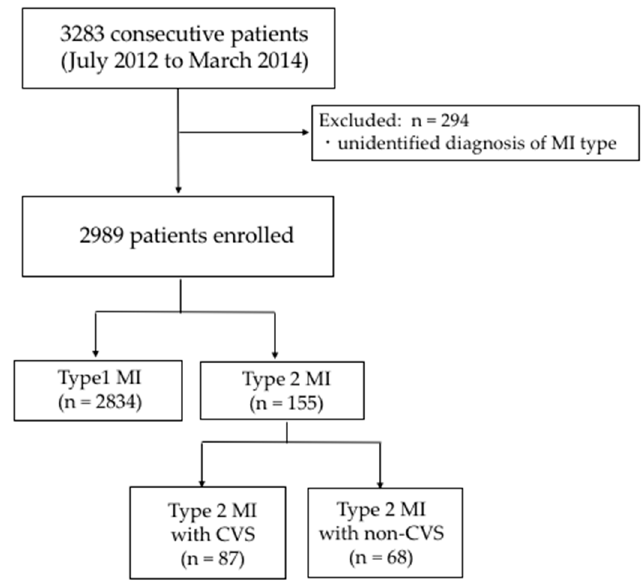
Figure 1. Flowchart of the current study. MI, myocardial infarction; CVS, coronary vasospasm